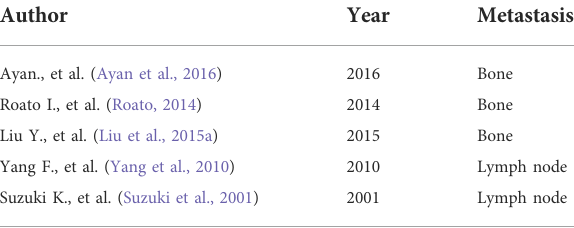
TABLE 5 Studies on other metastasis of lung cancer.